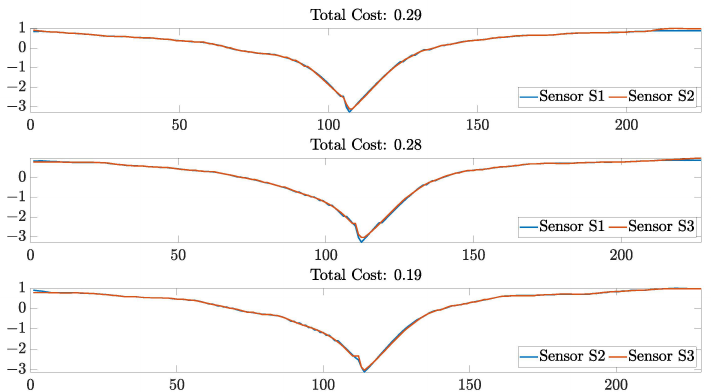
Figure 20. Data similarities are assessed by applying the DTW technique on the resistance data of each sensor pair for Cycle 40. The y axis on each plot represent the normalized resistance data; and the x axis on each plot represents the resistance sample number compared during the computation of the warping path of the DTW